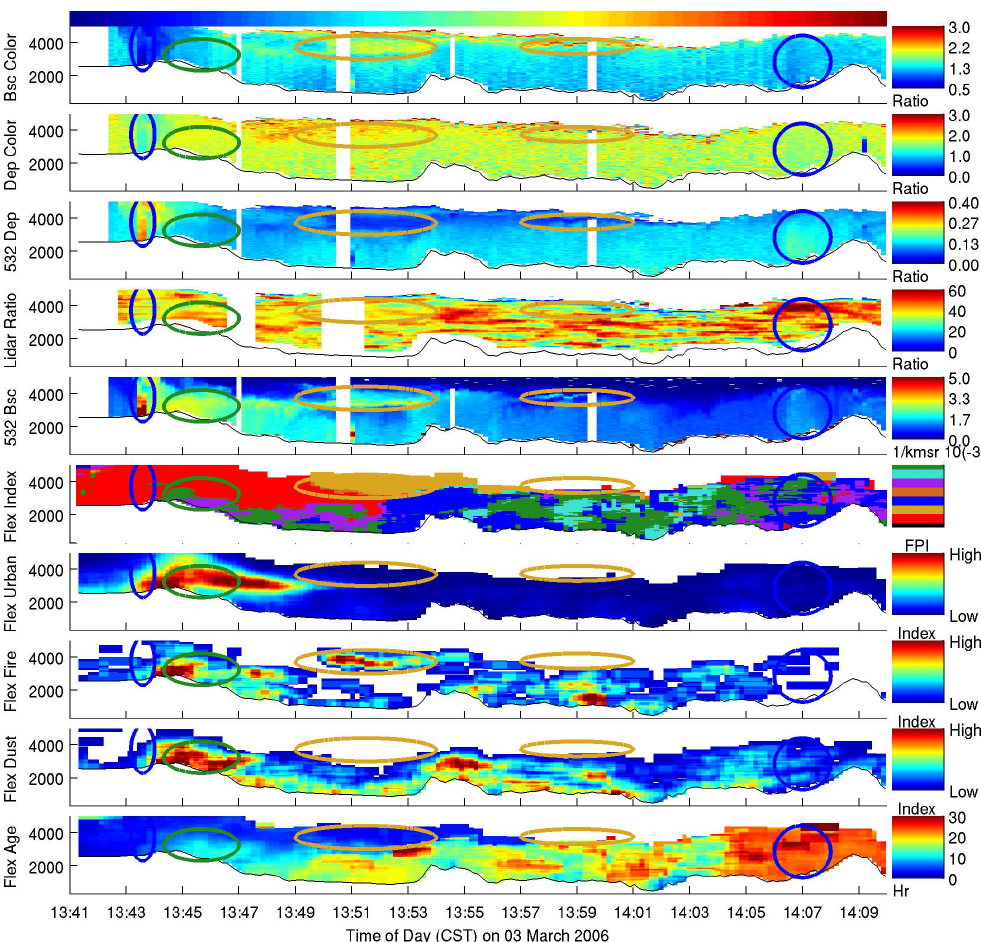
Fig. 10. Curtain plots of HSRL backscatter coefficients and intensive properties for southward flight along the urban plume on 3 March 13:41 to 14:10, along with Flexpart average age and particle count index for dust, fire and urban emissions. See Fig. 12 for Flexpart Particle Index (FPI) legend. The yellow ellipses show biomass burning plumes, the blue ellipses show dust plumes and the green ellipse shows a mixed plume. The y-axis is height above mean sea level. The colorbar across the top corresponds to the trajectory shown in Fig.